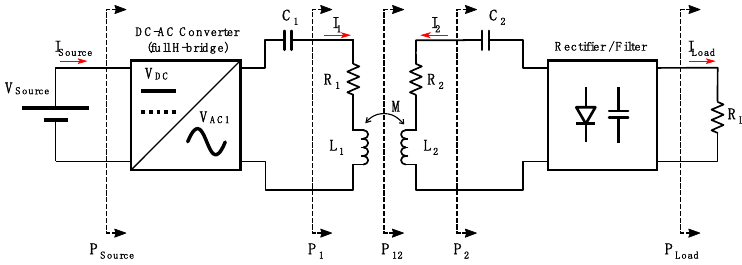
Figure 16. Spectral composition of WPT power over the air-gap, referenced to the first order harmonic.